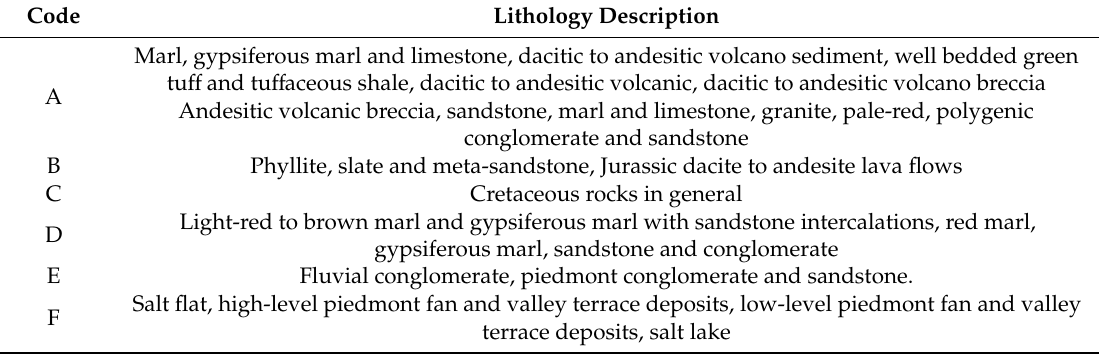
Table 2. Lithology of the Study